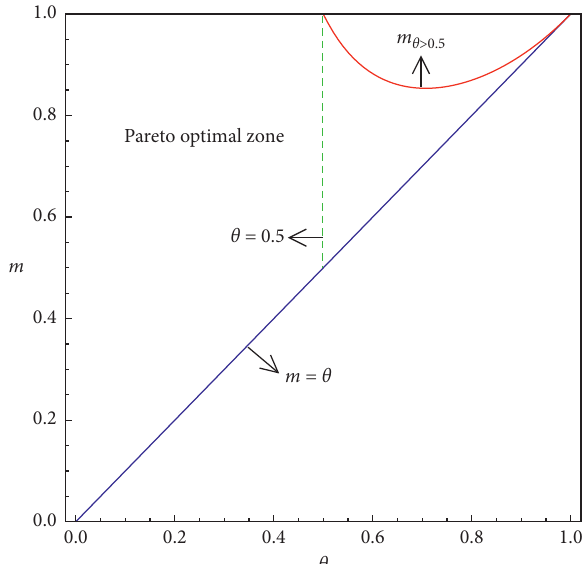
Figure 6: Pareto optimal zone under the rebate combination in both supply chain